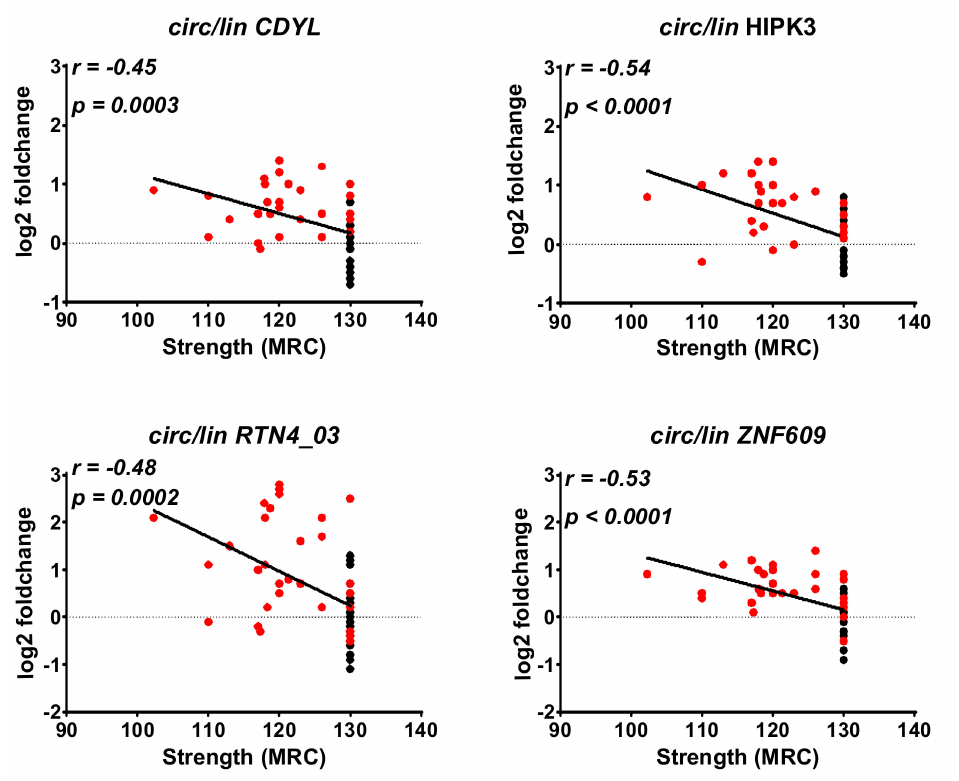
Figure 3. Correlation of muscle strength with circular-to-linear ratios of DM1-circRNAs. Pearson correlation values between significantly modulated circular-to-linear ratios identified in biceps brachii muscle biopsies and muscle strength were measured by Medical Research Council (MRC) megascore. DM1 = 30 (red dots), CTRL = 29 (black